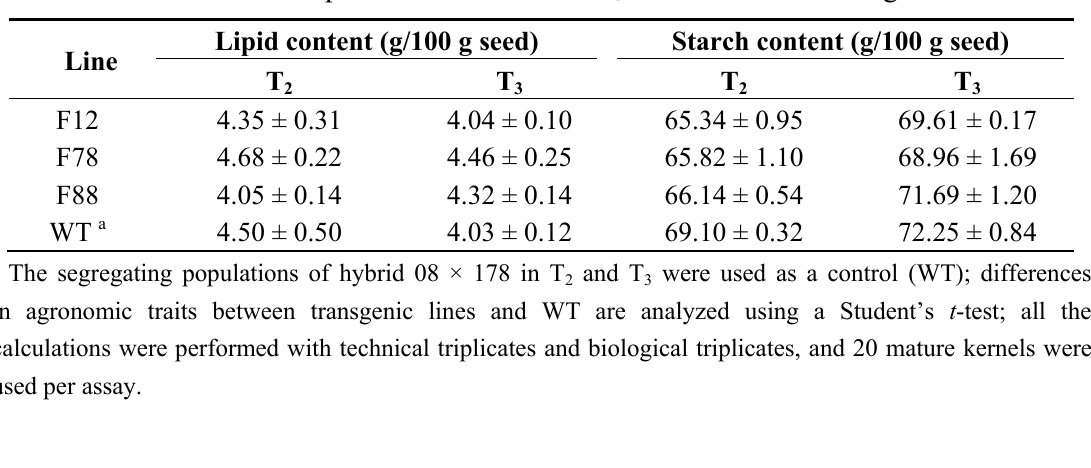
Table 3. Starch and lipid contents of T